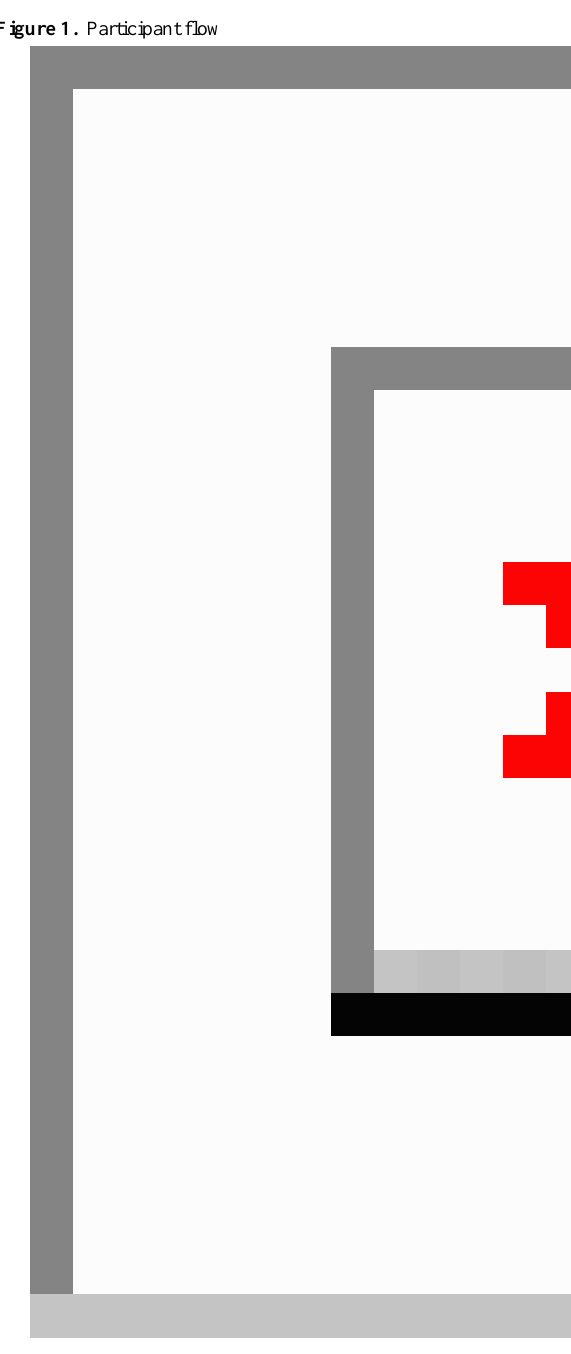
Figure 1. Participant